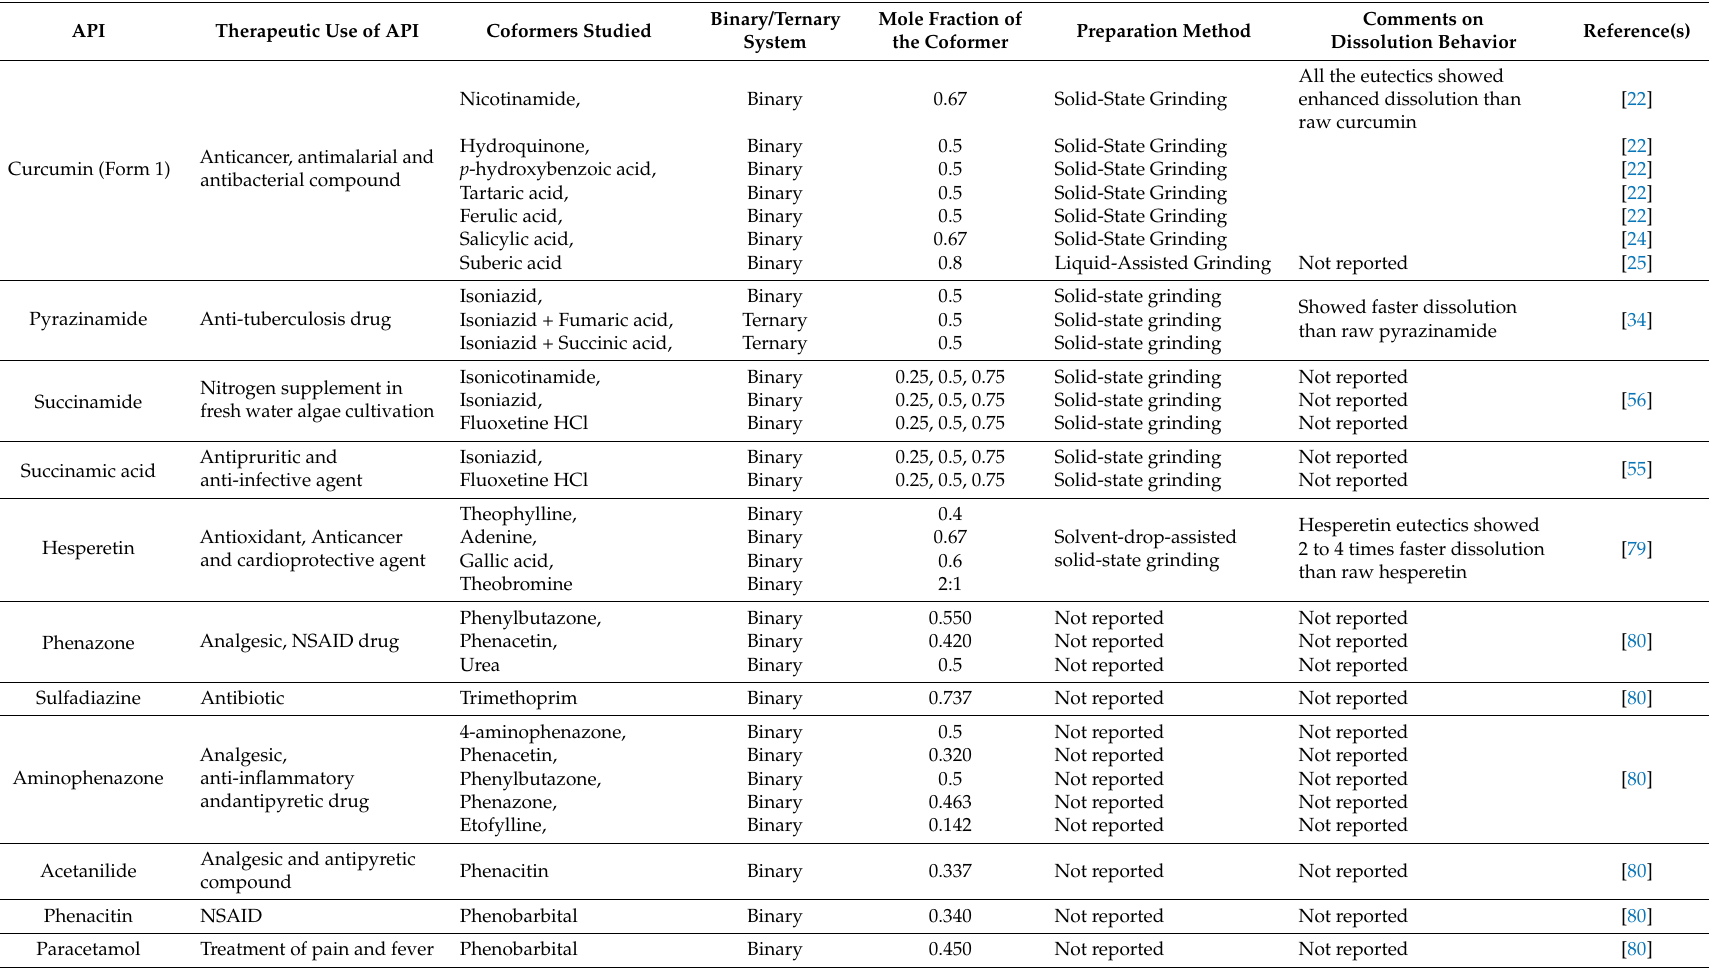
Table 3. Summary of few reports on pharmaceutical eutectics available in the